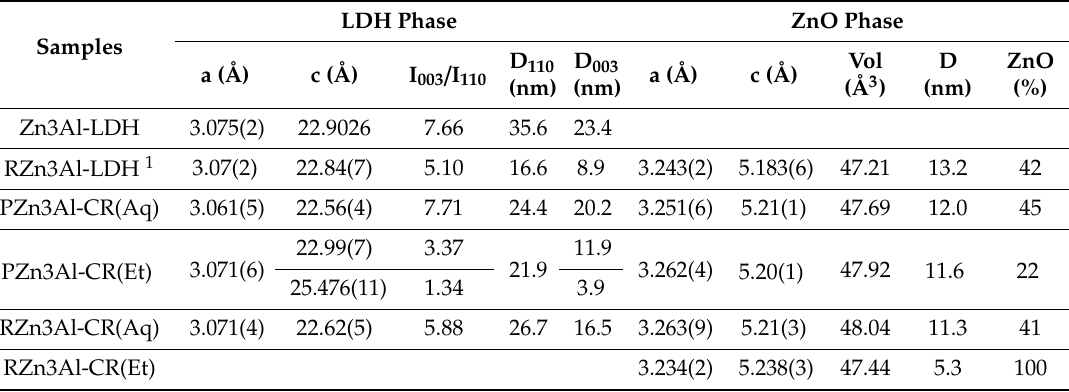
Figure 4. XRD patterns: ( a ) precipitated samples Zn3Al-LDH, PZn3Al-CR(Aq), PZn3Al-CR(Et); ( b ) reconstructed samples RZn3Al-LDH, RZn3Al-CR(Aq), RZn3Al-CR(Et). Table 2. Structural data of the samples obtained from XRD